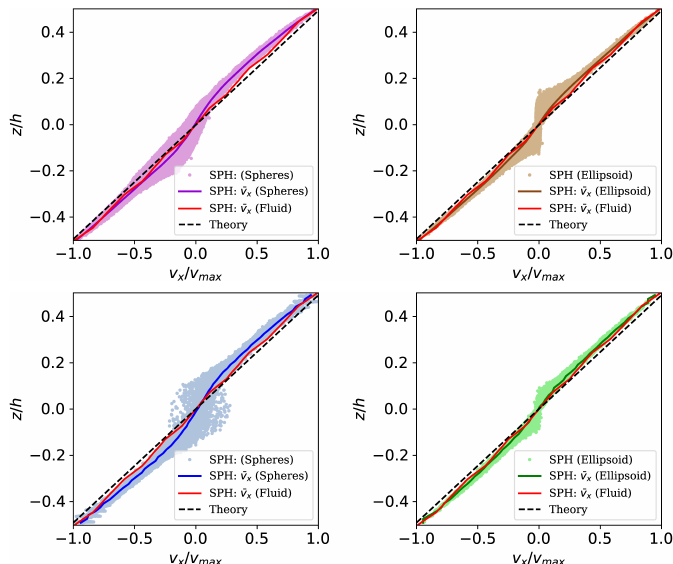
Figure 11. Resulting profile of velocity in e x -direction over coordinate e z for spherical solids ( left ) and ellipsoidal solids ( right ). While the black line represents the analytical solution for simple shear flow of a Newtonian fluid, the red line represents the mean velocity of a simulation of shear flow without solid aggregates (only fluid). Colored markers and and the same colored line represent SPH particle velocities and mean particle velocity, respectively. Investigated cases are shear flow with two spherical (pink, top left ), two ellipsoidal (brown, top right ), four spherical (blue, bottom left ) and four ellipsoidal (green, bottom right ) solid